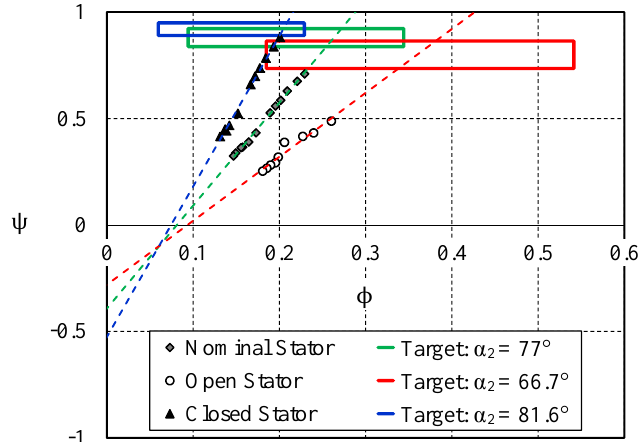
Figure 10. Loading-to-flow ( φ - ψ ) map theoretical approach applied to experimental data available for the PTM